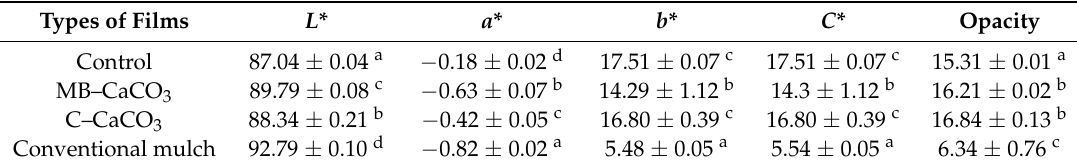
Table 3. Color and opacity of seaweed-based films and conventional mulch